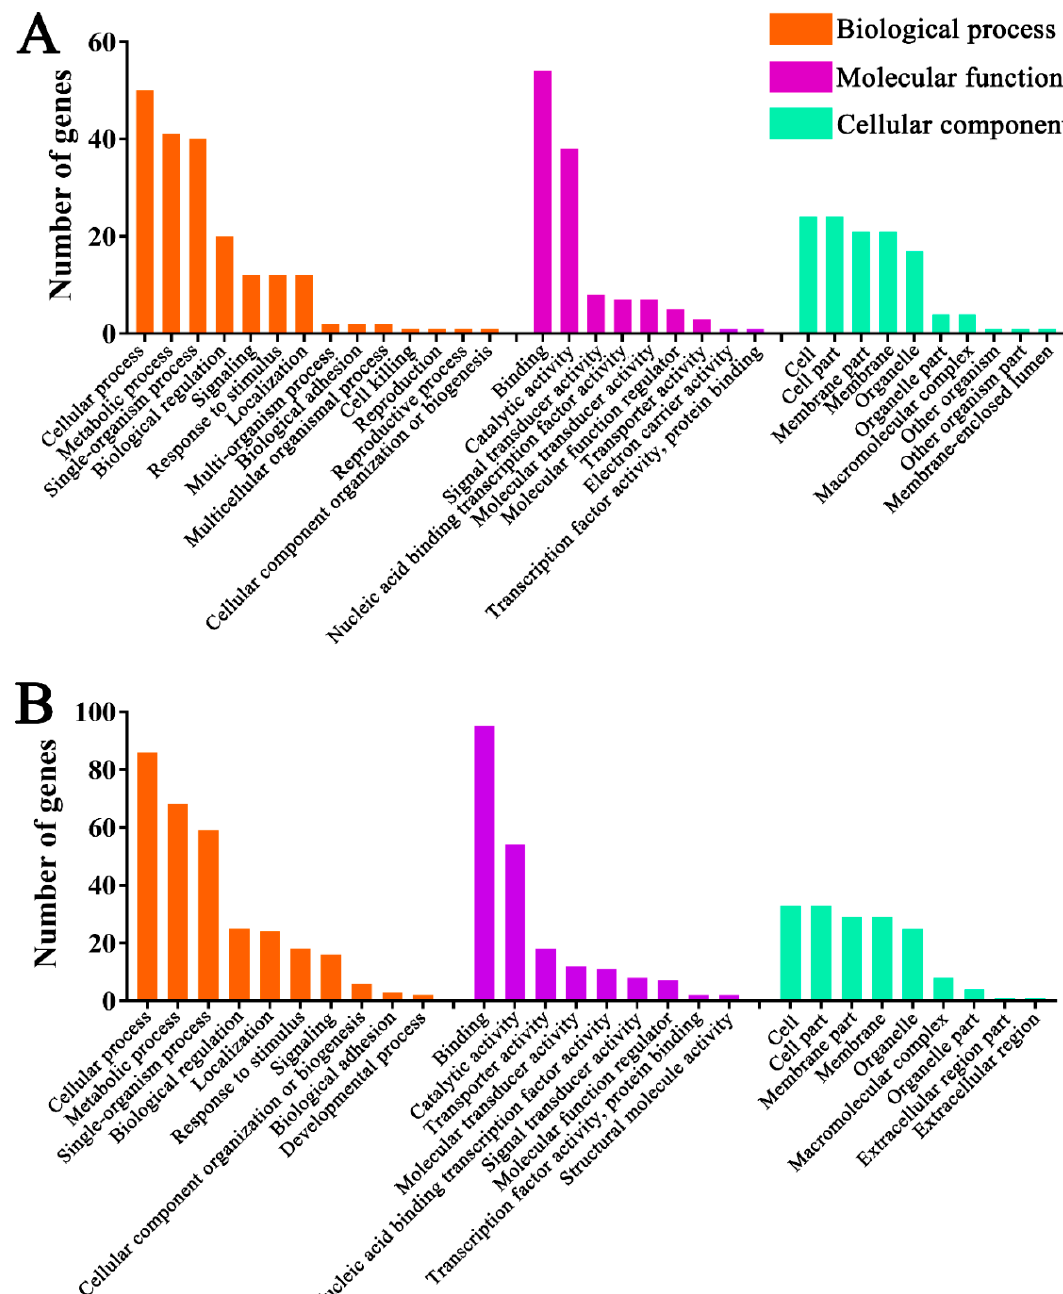
Figure 6. Gene ontology (GO) categorizations of target genes of DElncRNA-targeted miRNAs in Am7CK vs. Am7T ( A ) and Am10CK vs. Am10T ( B ).